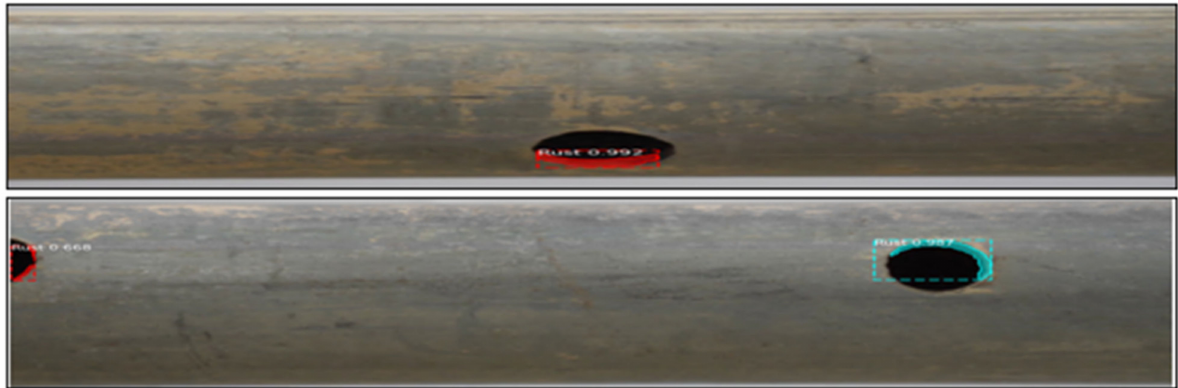
Figure 17. Predicted